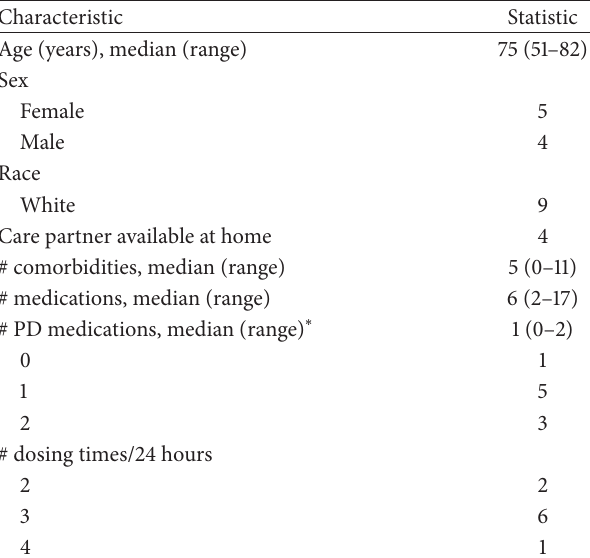
Table 1: Participant